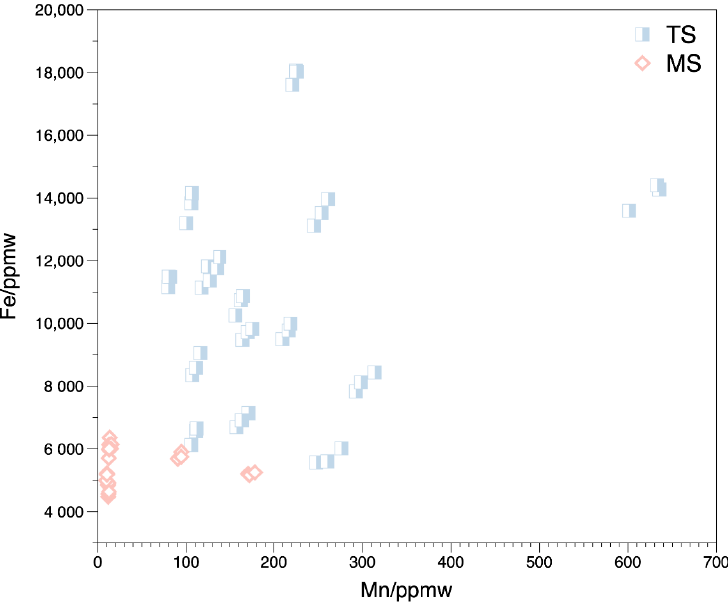
Figure 9. The scatter diagram of Fe vs. Mn reveals that Tanzanian purple spinels can be separated from Myanmar samples.